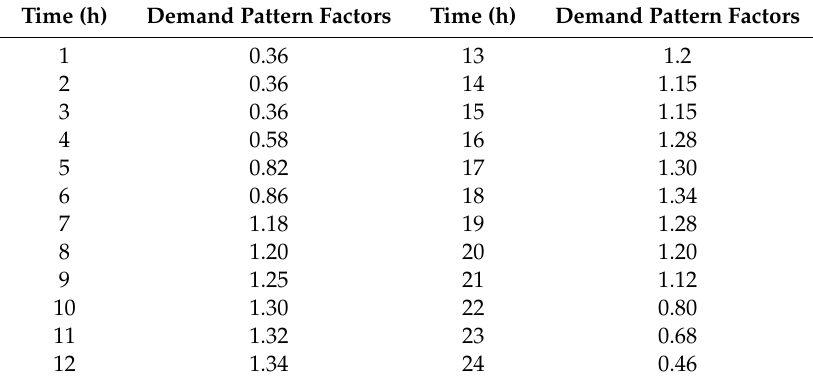
Table 4. Daily Demand Pattern Factors.